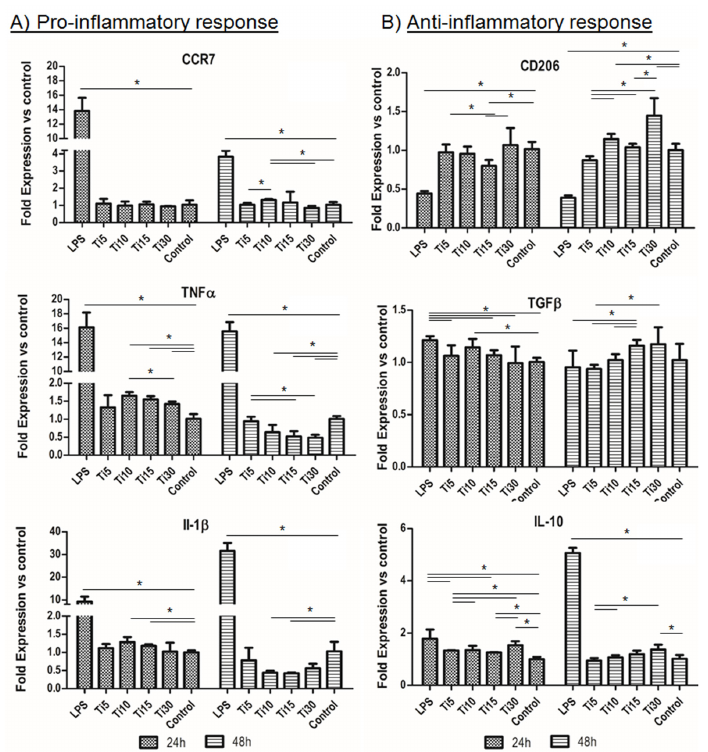
Figure 4. Immune response RNA analysis. RNA analysis of the inflammatory response in THP-1 cells from proinflammatory markers CCR7, TNF α , and IL-1 β ( A ) and anti-inflammatory markers CD206, TGF- β , and IL-10 ( B ). Cultured cells with extracts of titanium microparticles at 5 μ m, 10 μ m, 15 μ m, and 30 μ m were analyzed at 24 h and 48 h. LPS was used as a positive control of inflammation, while medium without particles was used as a negative control. * p < 0.05.